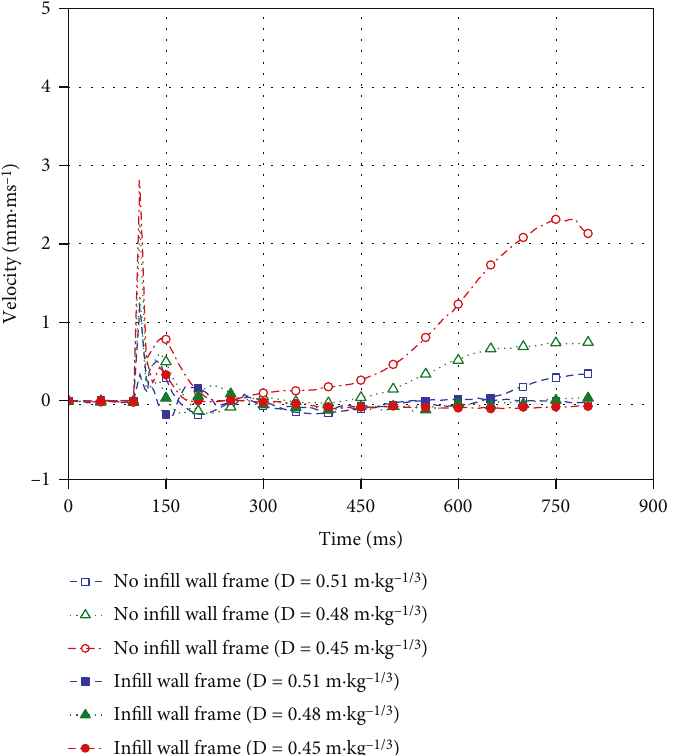
Figure 13: The Y -directional velocity at the midpoint of the second story side